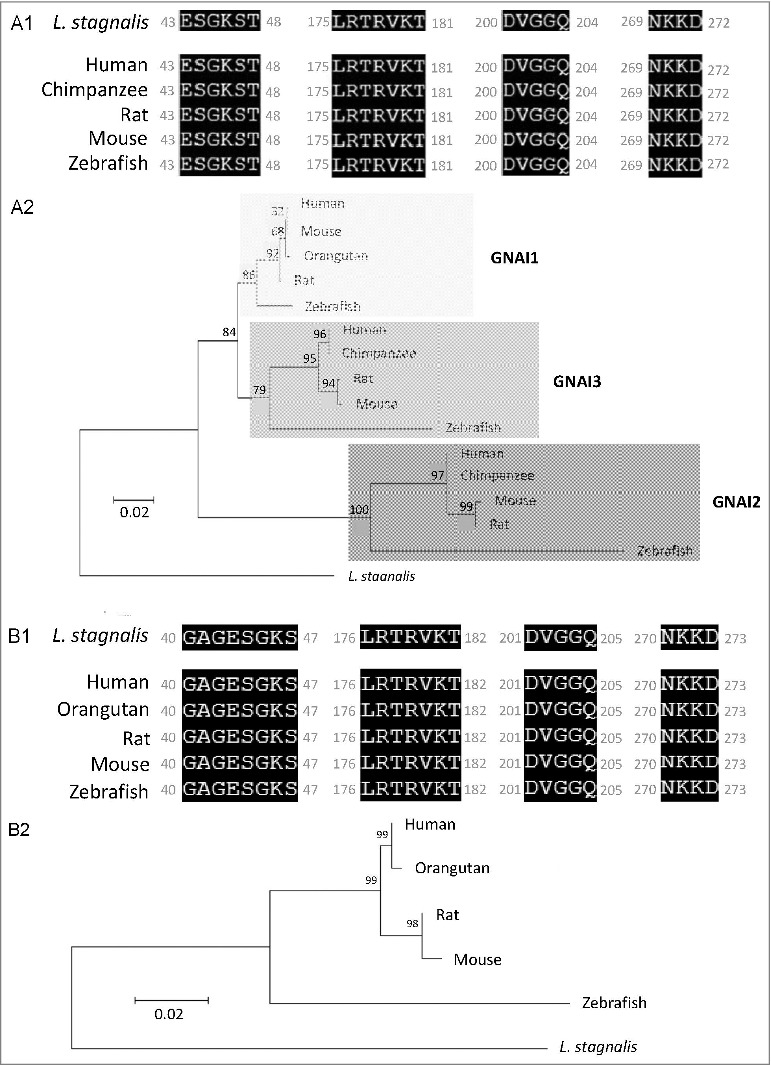
Protein sequence alignment and phylogenetic tree of G protein subunits in L. stagnalis. A-B,Amino acid sequence comparisons of the four nucleotide binding sites in the single L. stagnalis Gαi and Gαo orthologs with the vertebrate Gαi isoforms GNAI1-3 (A1) and Gαo (B1), respectively. As all four sites are identical across GNAI1-3 isoforms in human, chimpanzee, rat, mouse and zebrafish, only one instance is shown for simplicity. Phylogenetic analysis was conducted by the Maximum Likelihood method using the JTT+G model for Gαi (A2) and the LG+G model for Gαo (B2). C, Amino acid sequence comparisons of the seven WD repeat regions (WD1-7) of the single isoform L. stagnalis Gβ and vetebrate orthologs of Gβ1 (C1). Phylogenetic analysis was conducted by the Maximum Likelihood method using the WAG model (C2). D, Amino acid sequence comparisons of the single L. stagnalis Gγ isoform and vetebrate orthologs of Gγ2 (D1). Phylogenetic analysis was conducted by the Maximum Likelihood method using the LG model (D2). Conserved and similar sequences in alignments are colored as black and grey boxes, respectively. Bootstrap value from 500 replicates are shown next to each node. The scale bars indicate the estimated evolutionary distance in the units of the number of amino acid substitutions per site.